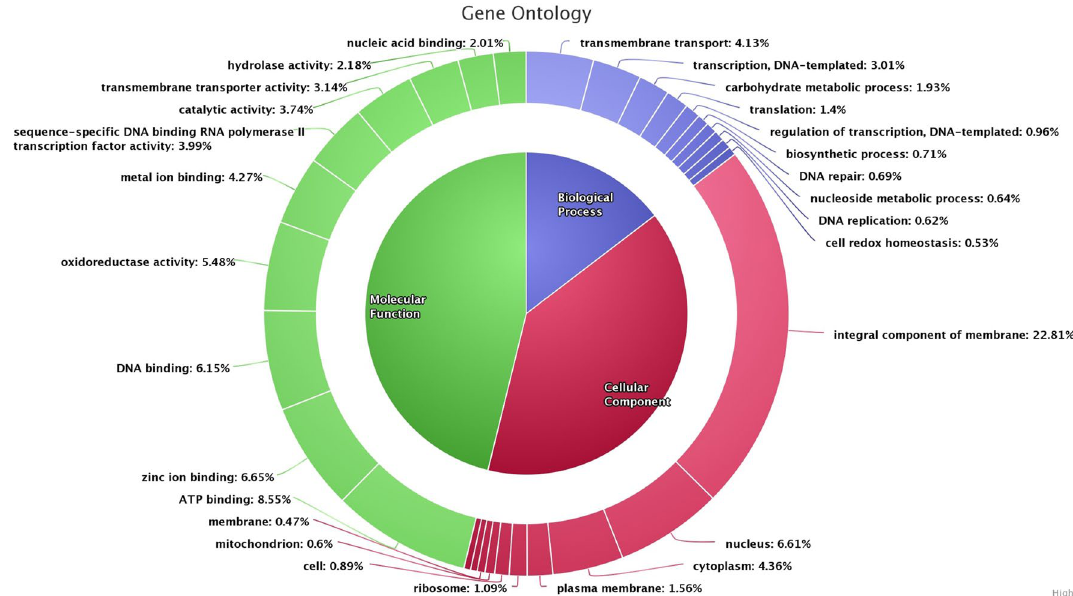
Figure 8. Cluster of orthologous group (COG) functional classification of genes in A. sydowii BOB A1 genome corroborate the presence of genes involved in biodegradation (oxidoreductase, catalytic and hydrolase protein) (https:// www. highc harts. com/ demo/ pie- donut).